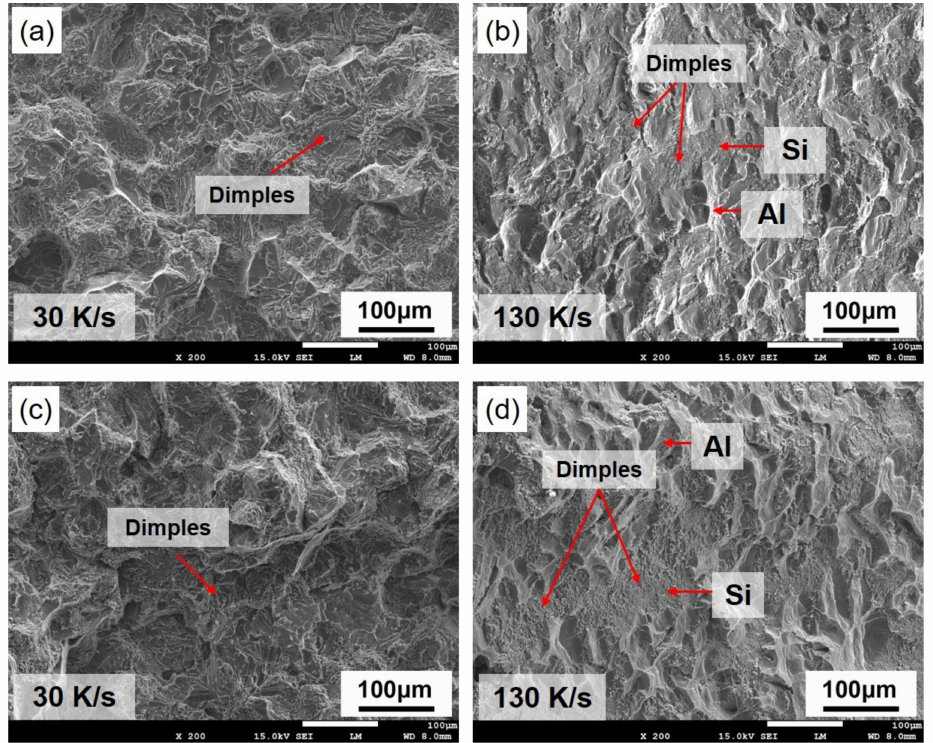
Figure 13. SEM pictures showing the fractures of ( a , b ) Al7SiMg and ( c , d ) Al7SiMg + 0.4La at the cooling rate of 30 and 130 K /